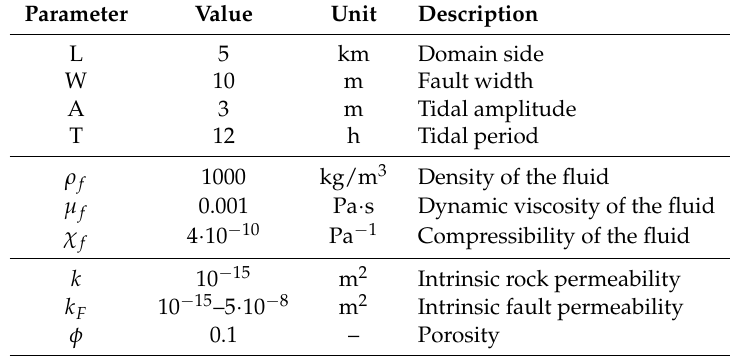
Table 1. Parameters of the two-dimensional (2D) model with Darcy’s law (Figures 2–5).